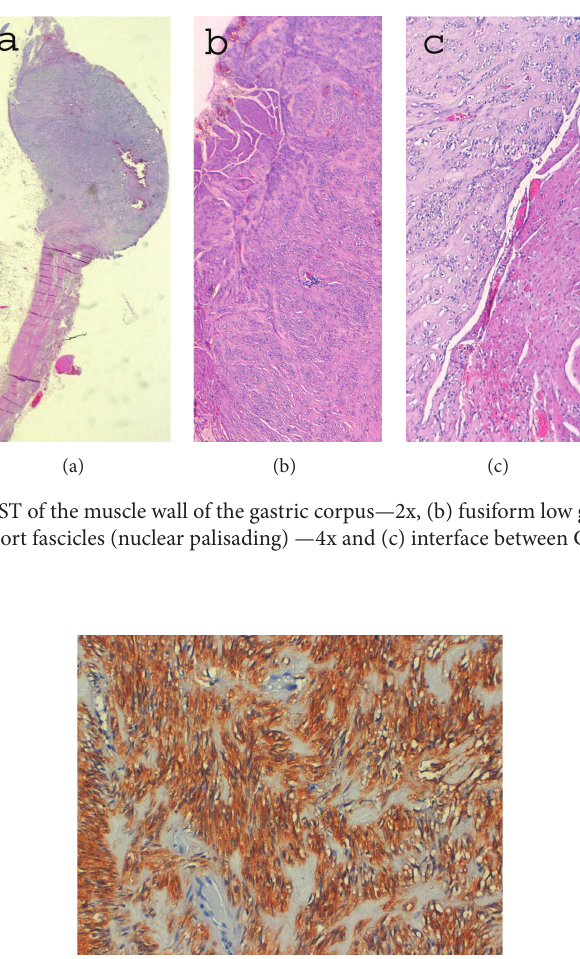
Figure 4: Immunohistochemical features of GIST: c-KIT/CD117 (tyrosine kinase growth factor receptor)